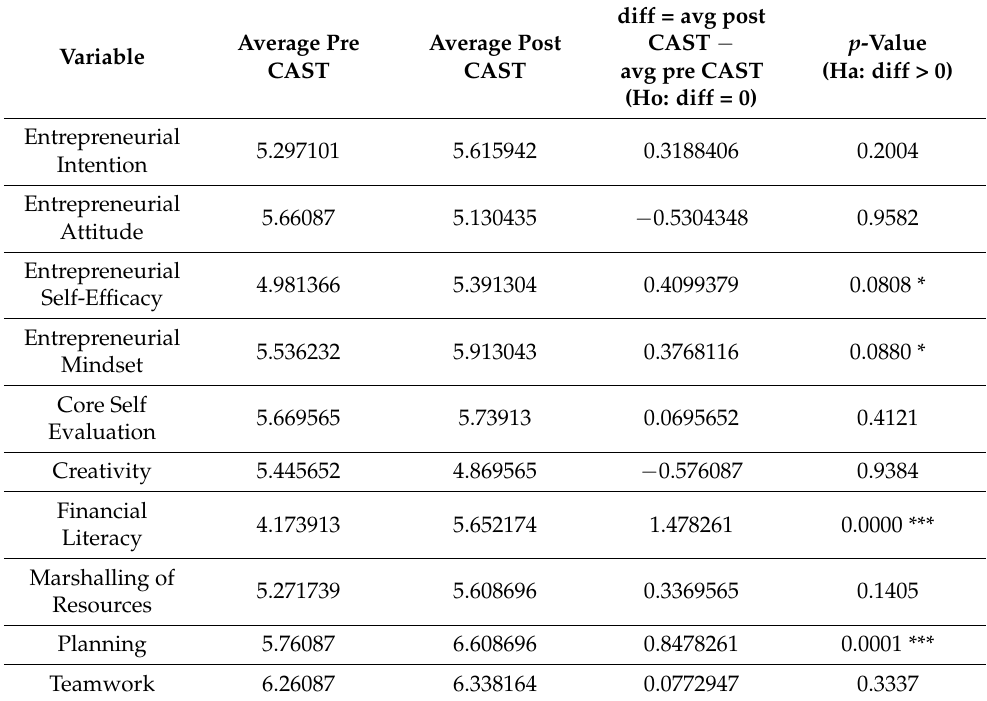
Table A4. Output of t -tests on entrepreneurial characteristics, pre- and post-course, of the MSc students.